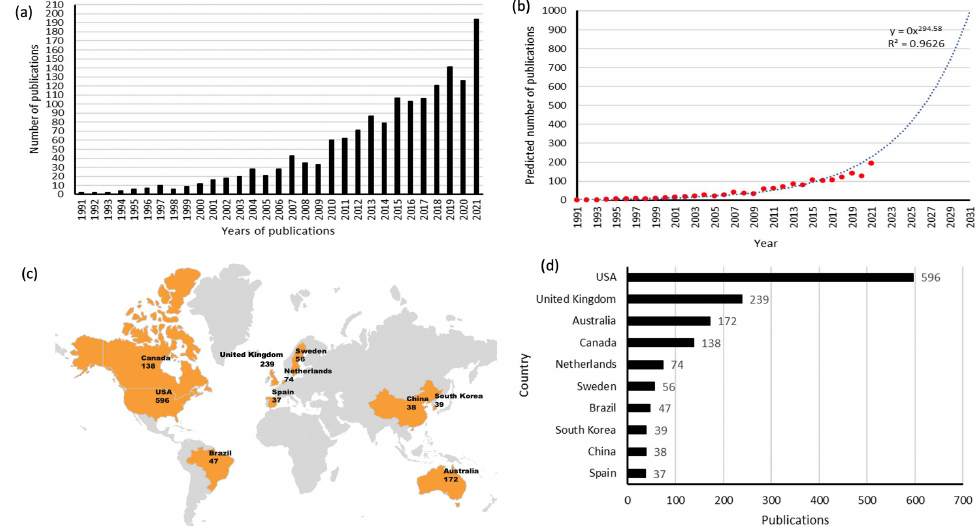
Figure 2. ( a ) The number of cumulative publications; ( b ) Model fitting curves of global publication trends; ( c ) The distribution world map of publications; ( d ) The top 10 countries of total publica- tions.